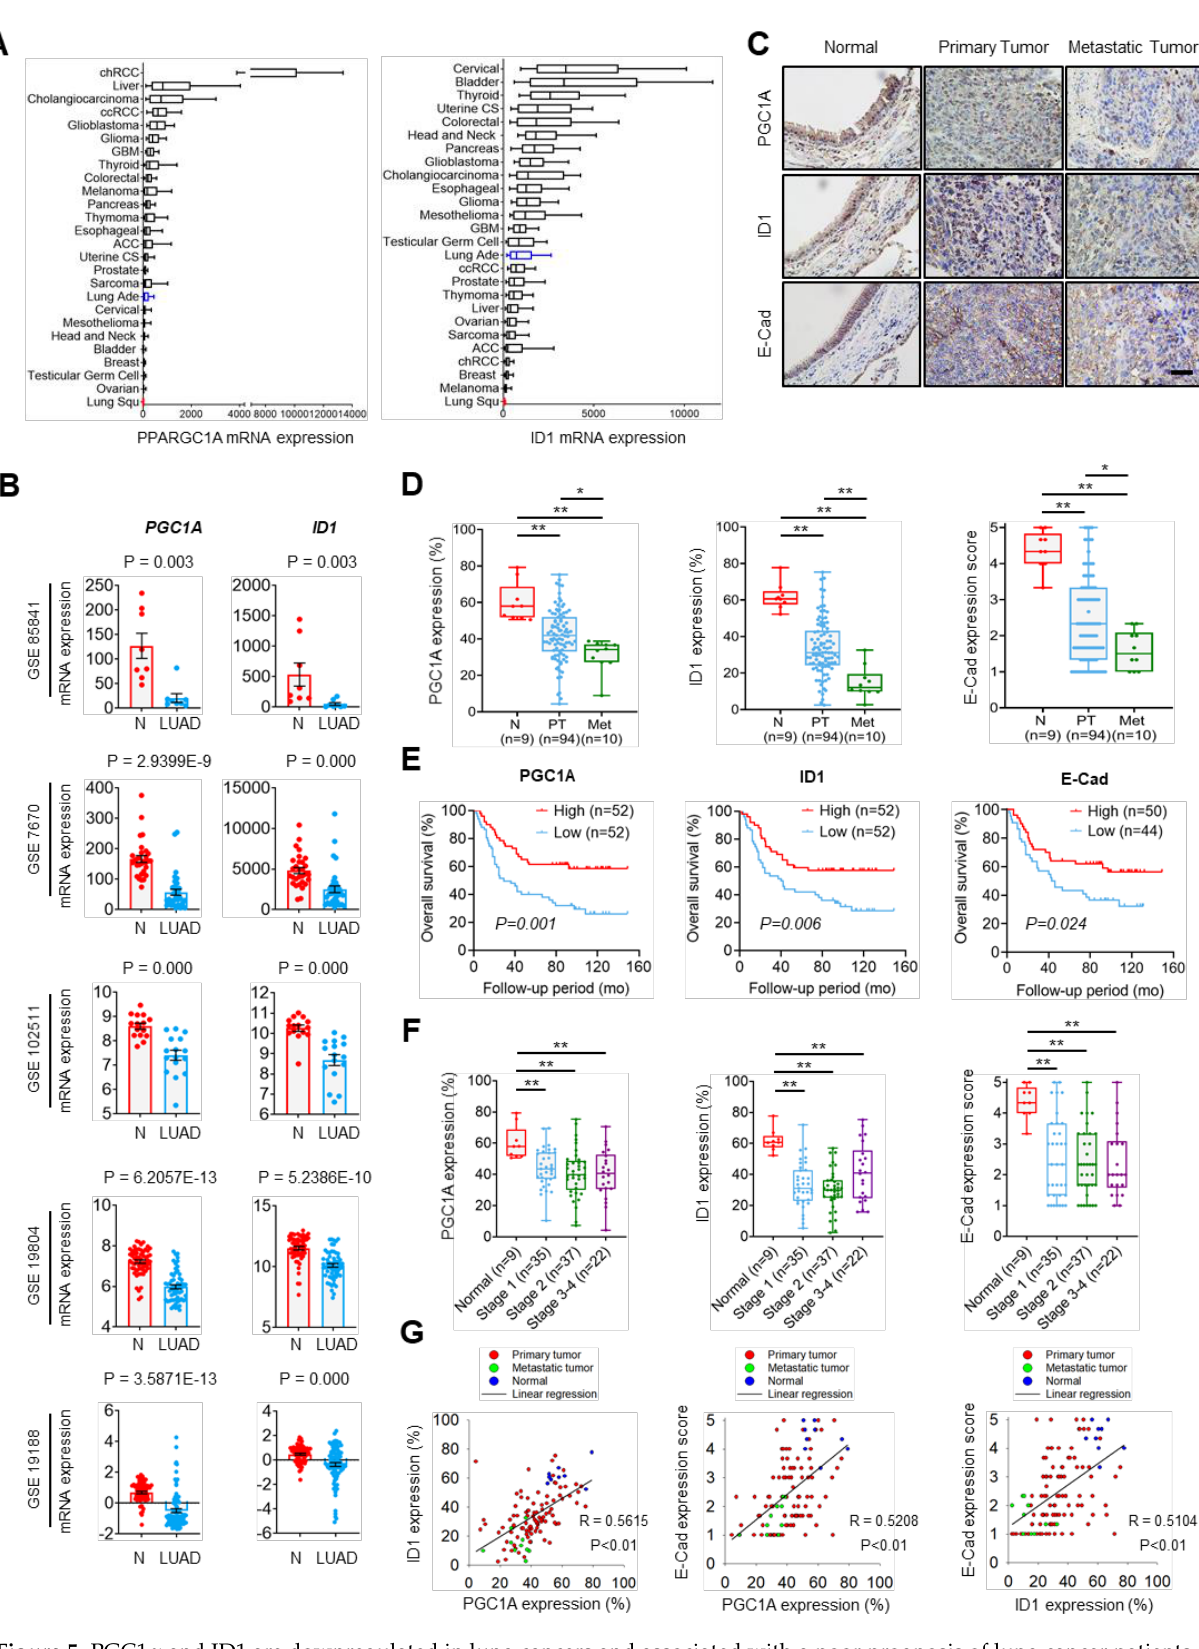
Figure 5. PGC1α and ID1 are downregulated in lung cancers and associated with a poor prognosis of lung cancer patients. ( A ) The mRNA expressions of PPARGC1A (PGC1α) or ID1 in 26 human cancer tissues were evaluated by using RNA Seq V2 RSEM. The box plots show the distribution of values and the middle lines within boxes show the mean values. All data were downloaded from cBioportal (www.cbioportal.org (accessed on 1 January 2020). ( B ) PGC1α and ID1 mRNA expres-